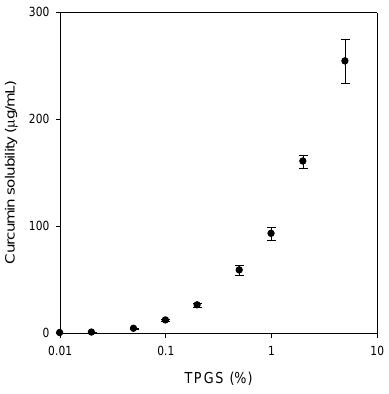
Figure 1. Solubility of curcumin was determined with increasing amount of TPGS. Each bar represents the mean ± S.D. of three independent experiments.